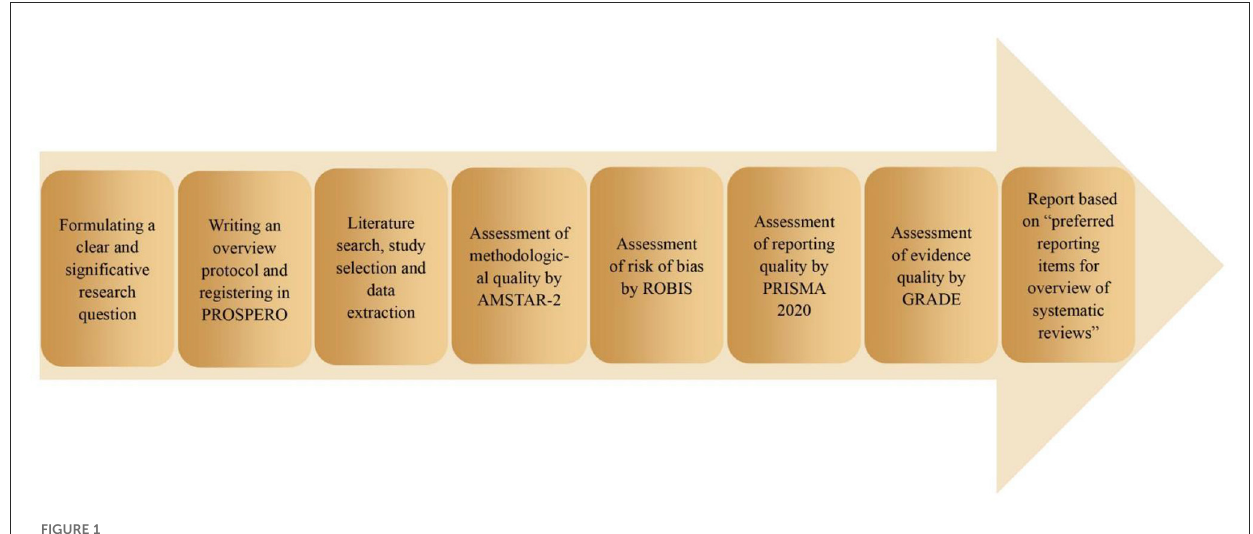
FIGURE1 The process of this overview.